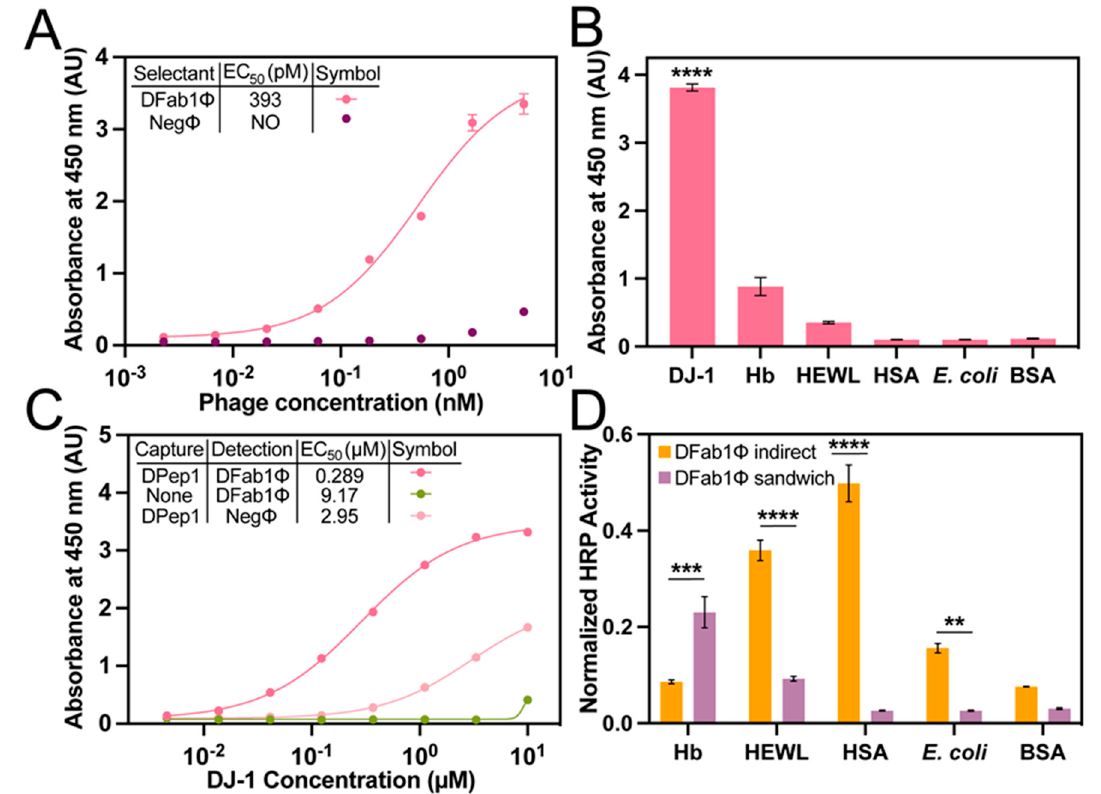
Figure 4. Sensitivity and specificity determination of DFab1. ( A ) A dose-dependent direct phage assay with DFab1 Φ and Neg Φ . Data were fit to a four-parameter logistic curve and yielded picomolar EC 50 values for the DFab1 Φ interaction with DJ-1. Error bars represent SEM ( n = 3). NO = not observed. ( B ) An indirect phage assay with DJ-1, Hb, HEWL, HSA, E. coli lysate, and BSA